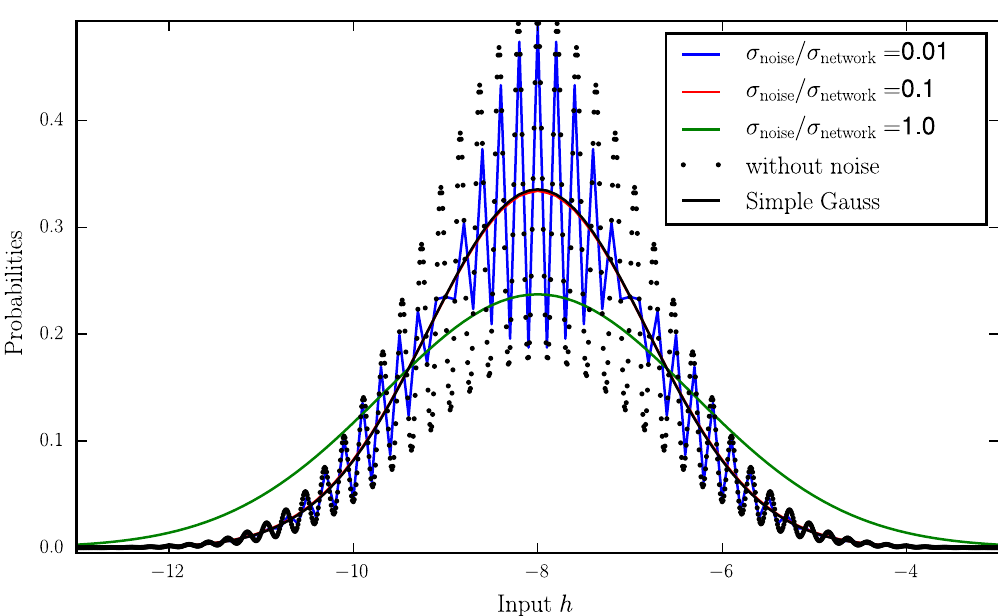
Fig 8. Distribution of inputs from binary neurons for different noise levels. Probabilitydistribution of synaptic input h i = ∑ j J ij n j + ξ i of a neuronin a network of independently active cells n j with h n E i = h n I i = 0.2 and synaptic j was deliberatelychosen to be large becauseonly then the convolution of a binomial weights j I = − 0.21, j E = 0.01. j j E j I distribution “squeezed”to the step size j E with the binomialdistribution squeezedto the step size | j I | results in a probabilitydistribution with many local maxima leadingto the impressionof an oscillation. The noiselesscase ξ i = 0 is shown as black dots. The solid black curve indicatesthe Gaussianapproximation (cf. e.g. Eq (16), here without perturbation) of this distributionfrom the main text. This distributionappearsin the expectationvalues of the activationfunction F (cf. e.g. Eq (1)): It is a Gaussiandistributionwith the mean μ = K E j E m E + K I j I m I and the variance s 2 ¼ K ð 1 (cid:0) m Þ þ K ð 1 (cid:0) m Þ of the originalbinomial distributionsBinom(m E , K E ), Binom(m I , K I ). The j 2 m j 2 m E E E I I I network E I Þ of different magnitudes σ noise , given in other curves indicateconvolutions with the Gaussiannoise x (cid:24) N ð 0 ; s noise units of the noise level σ network intrinsicallyproducedby the network.